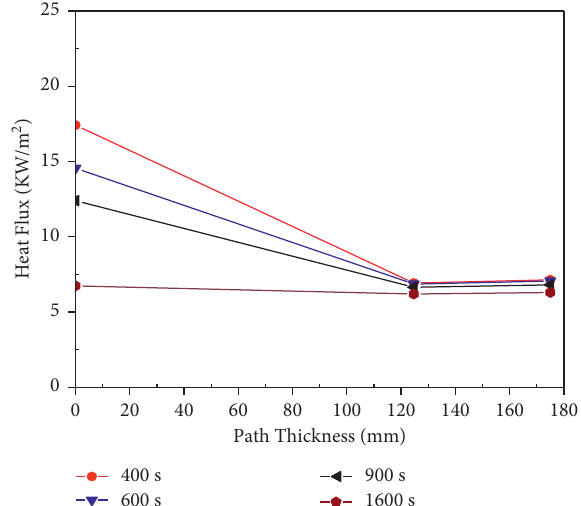
Figure 13: Hoop stress distribution through inlet nozzle-inner RPV wall intersection (path) thickness at different times.